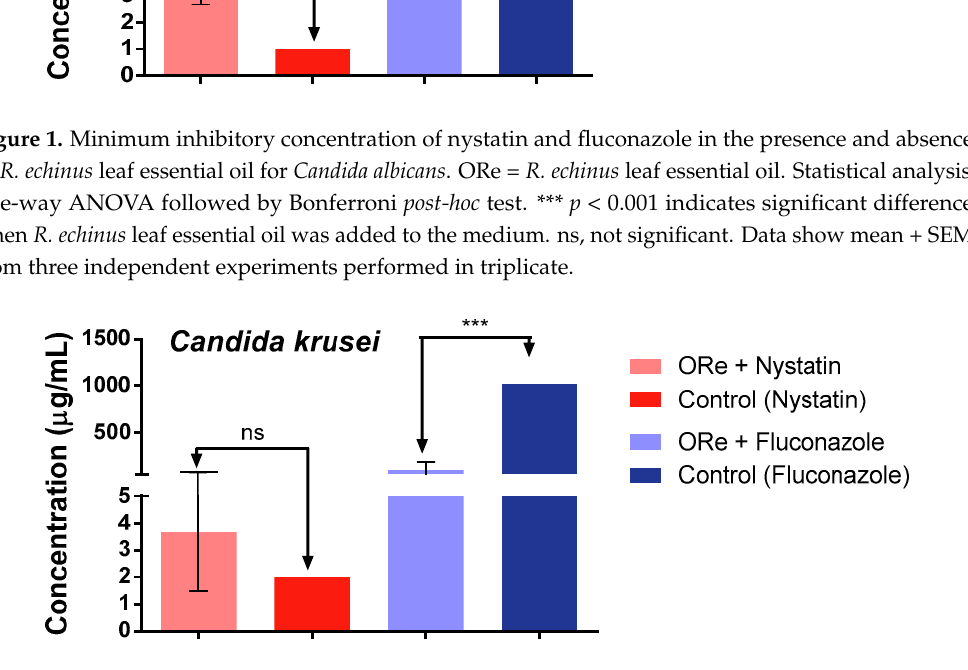
Figure 2. Minimum inhibitory concentration of nystatin and fluconazole in the presence and absence of R. echinus leaf essential oil for Candida krusei . ORe = R. echinus leaf essential oil. Statistical analysis: one-way ANOVA followed by Bonferroni post-hoc test. *** p < 0.001 indicates significant difference when R. echinus leaf essential oil was added to the medium. ns, not significant. Data show mean + SEM from three independent experiments performed in triplicate.